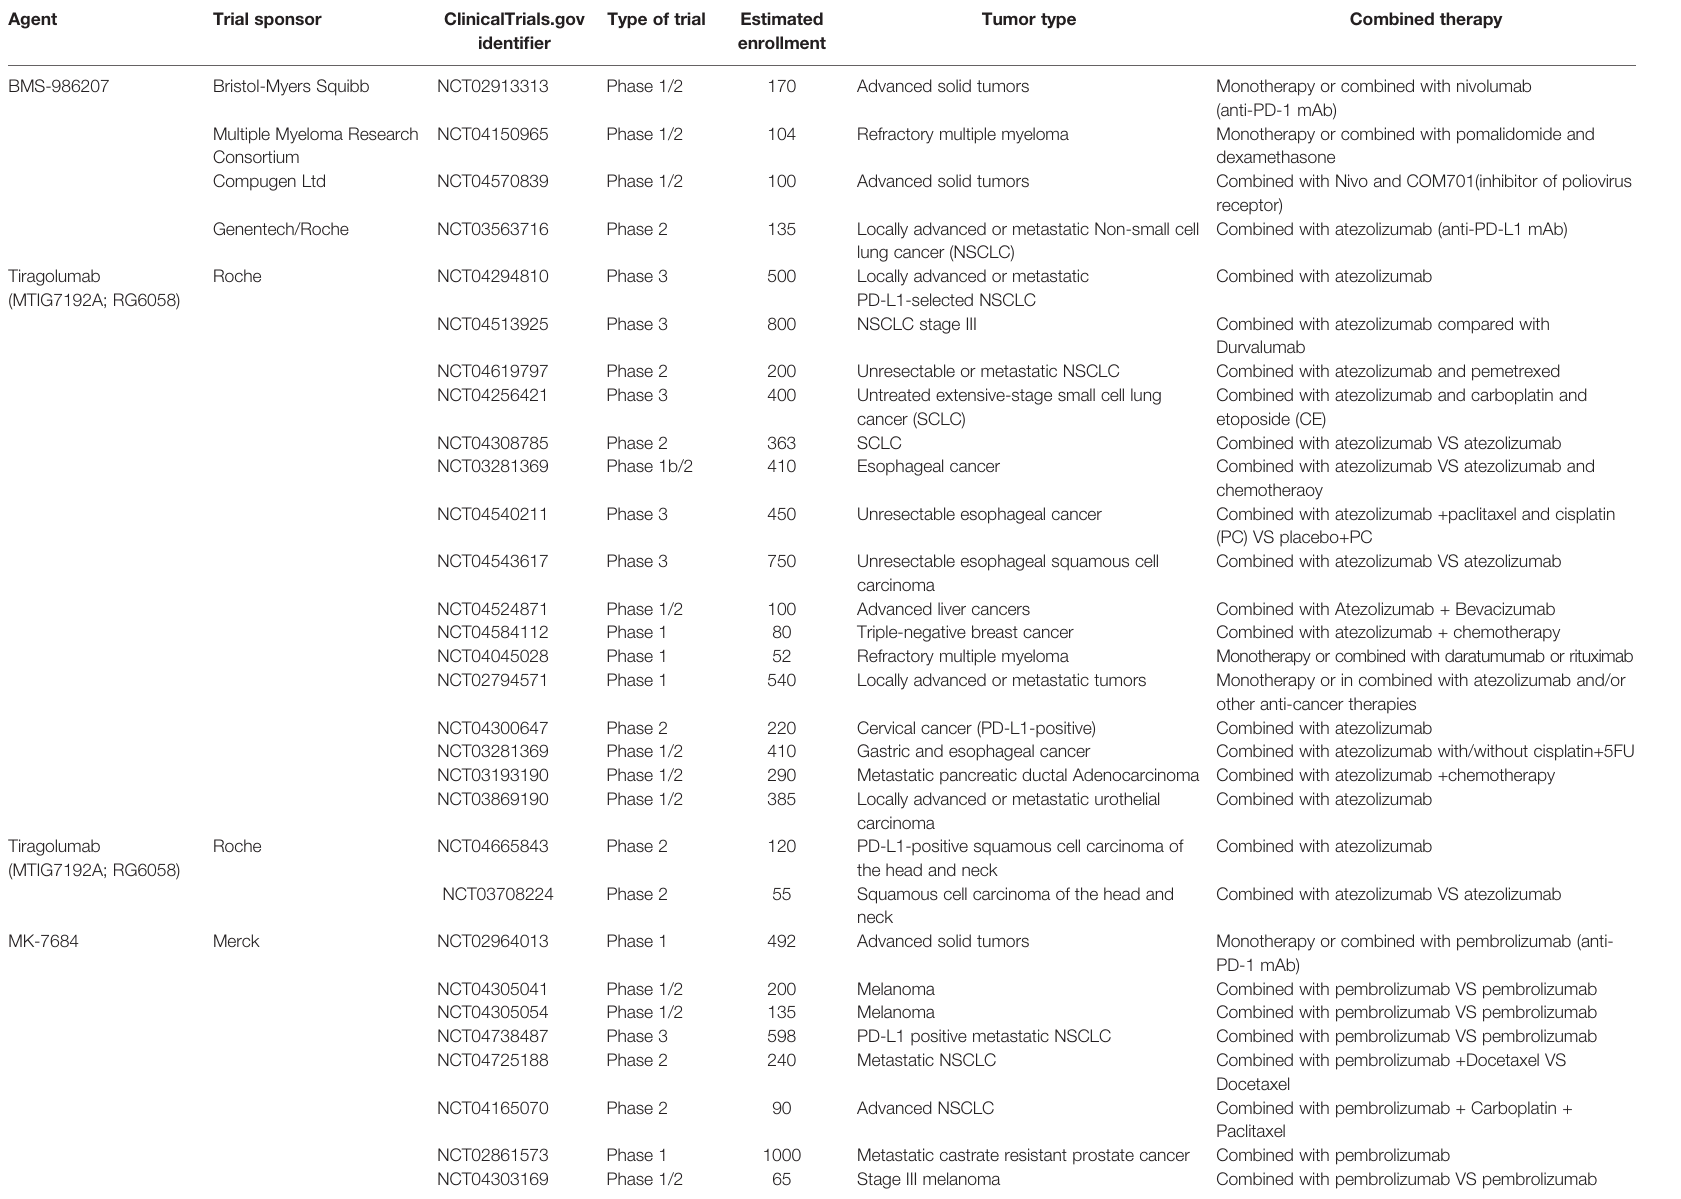
TABLE 1 | Currently ongoing clinical trials involving human anti-TIGIT